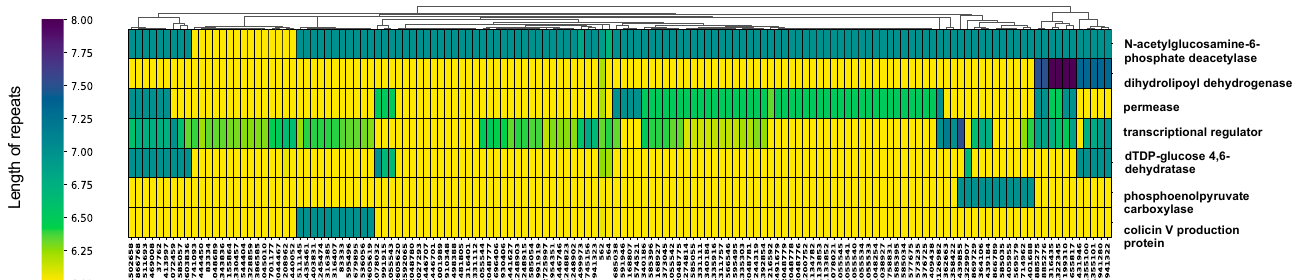
Figure 2. Variation in repeat length in intragenic homopolymeric tracts (HPTs) across Escherichia strains. The cluster map shows genes with significantly-variable intragenic HPTs in the genus Escherichia clustered by their repeat lengths. The horizontal axis shows the gene (protein) name, and the vertical axis shows the corresponding NCBI Taxonomy ID. The cluster map of all observed intragenic HPTs was shown in Figure S4. The color of the heatmap corresponds to the length of the repeats, with yellow and dark blue colors indicating the shortest and longest repeat lengths, respectively.